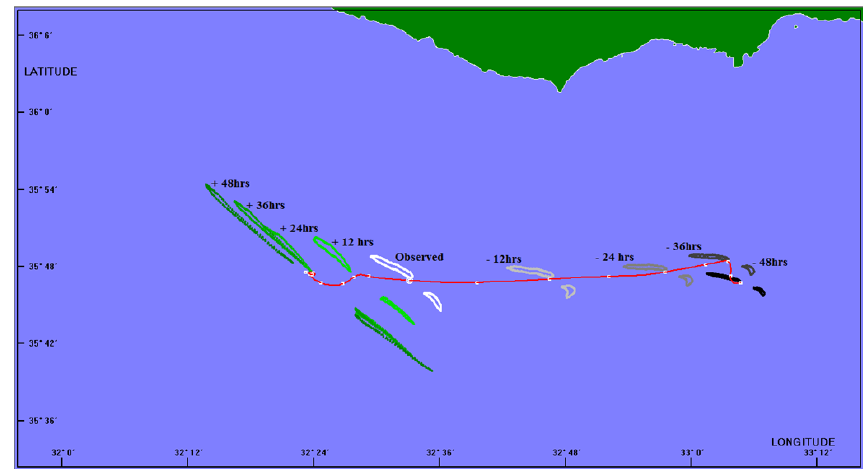
Fig. 3. Forecast and hindcast positions shown at intervals of 12 hours for the slick shown in Fig. 2a. Forecasts are shown in shades of green and hindcasts in shades of grey, while the observed position is shown in white.